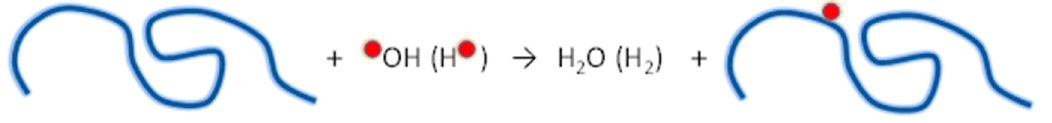
Figure 15. Formation of randomly-located carbon-centered polymer radical as a result of hydrogen abstraction by hydroxyl radicals or hydrogen atoms from a polymer chain.